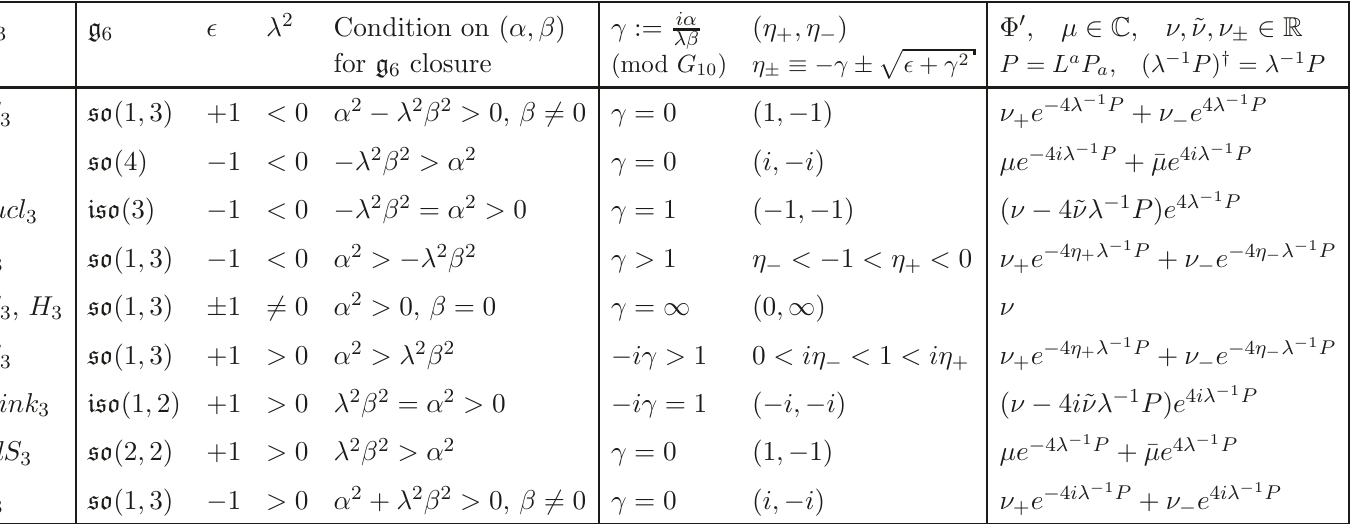
Table 1 . g 6 -invariant M 3 -foliations arising in the bosonic models, with I standing for instantons, and FRW k and DW k , respectively, standing for FRW-like solutions ( ǫ = 1) and domainwalls ( ǫ = +1) with foliates with curvatures of sign k = sign( ǫα 2 − isometry algebra of the ( A ) dS 4 vacua are governed by a vector L a with L 2 = ǫ and two real parameters α, β > 0. The last column contains the corresponding g 6 -invariant initial data for the Weyl zero-form. Two families of foliations with k = and the